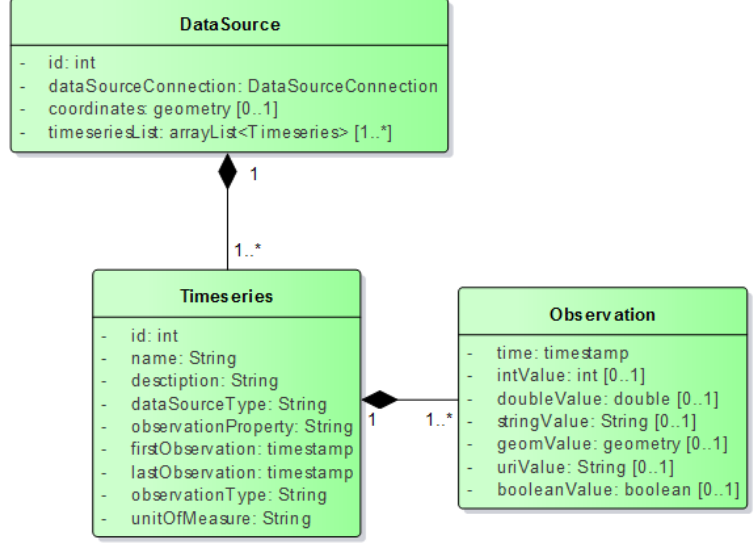
Figure 4. Key resources of InterSensor